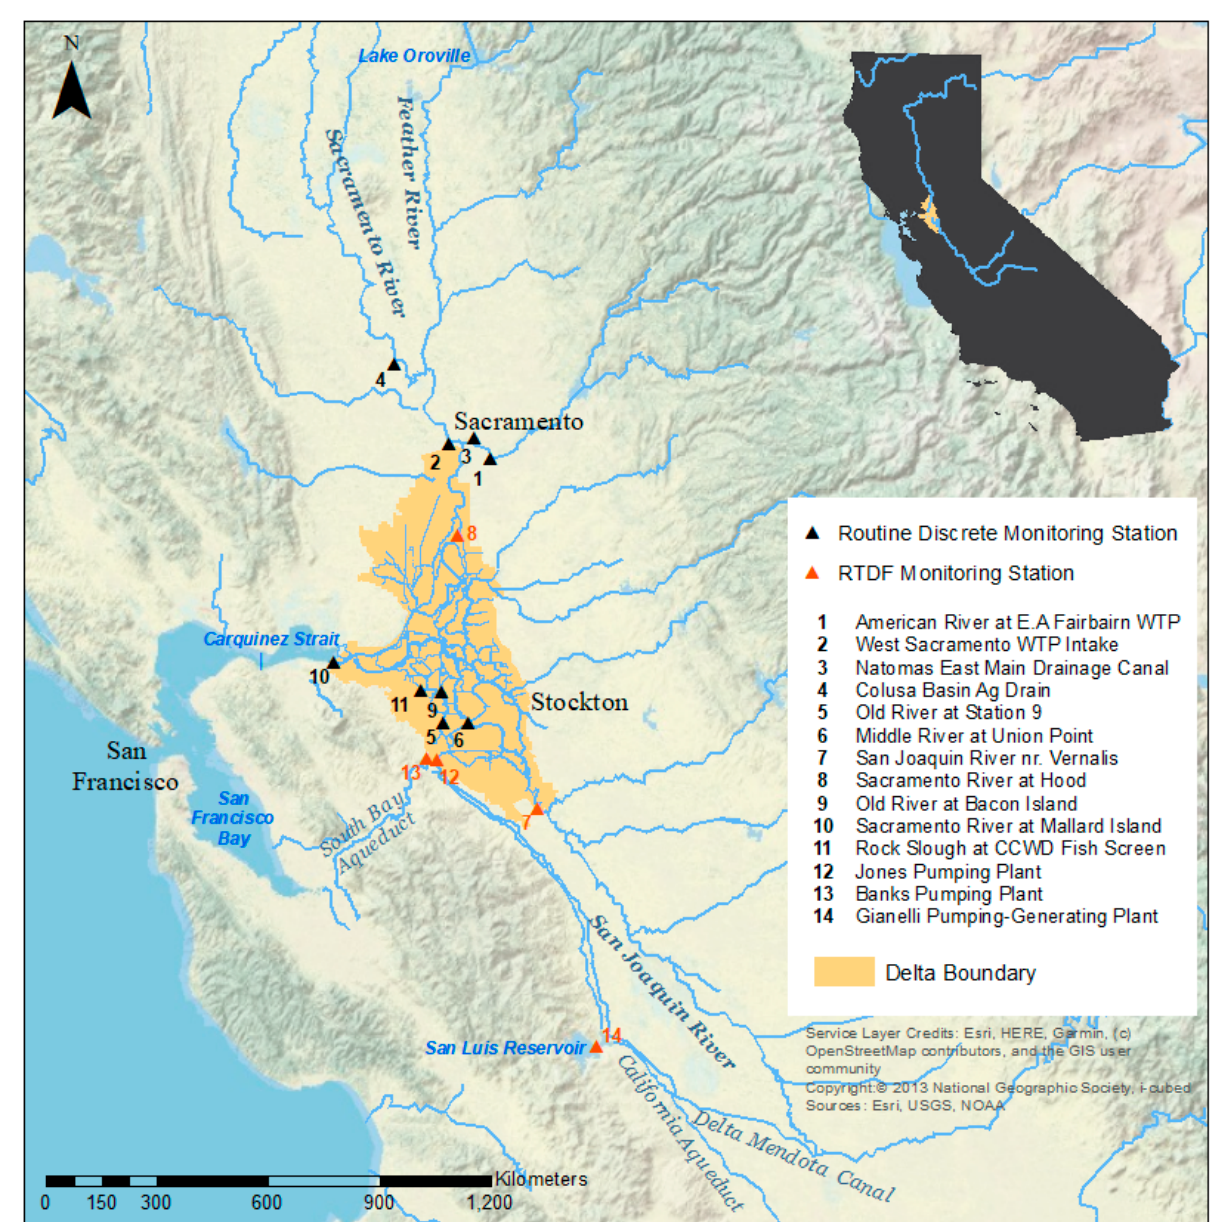
Figure 1. Map of study area identifying MWQI routine discrete and real time monitoring locations (noted as RTDF stations, for real time data forecasting).